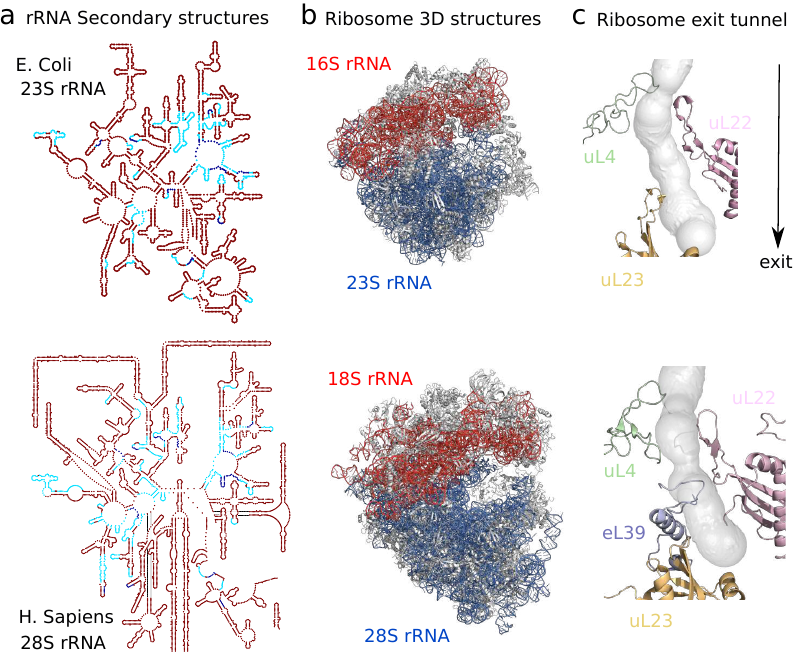
Figure 1. Number of structures related to the ribosomes and deposited in the Protein Data Bank (PDB) over the past 20 years. Data collected on rcsb.org [16].